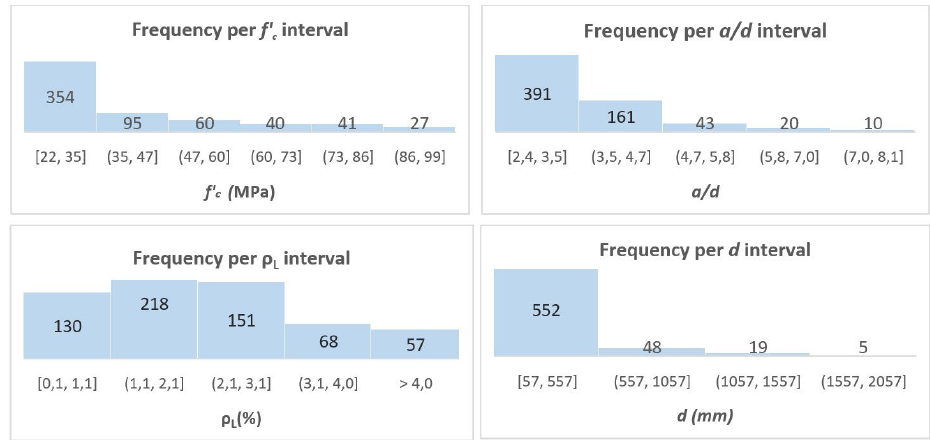
Figure 3- Distribution of the